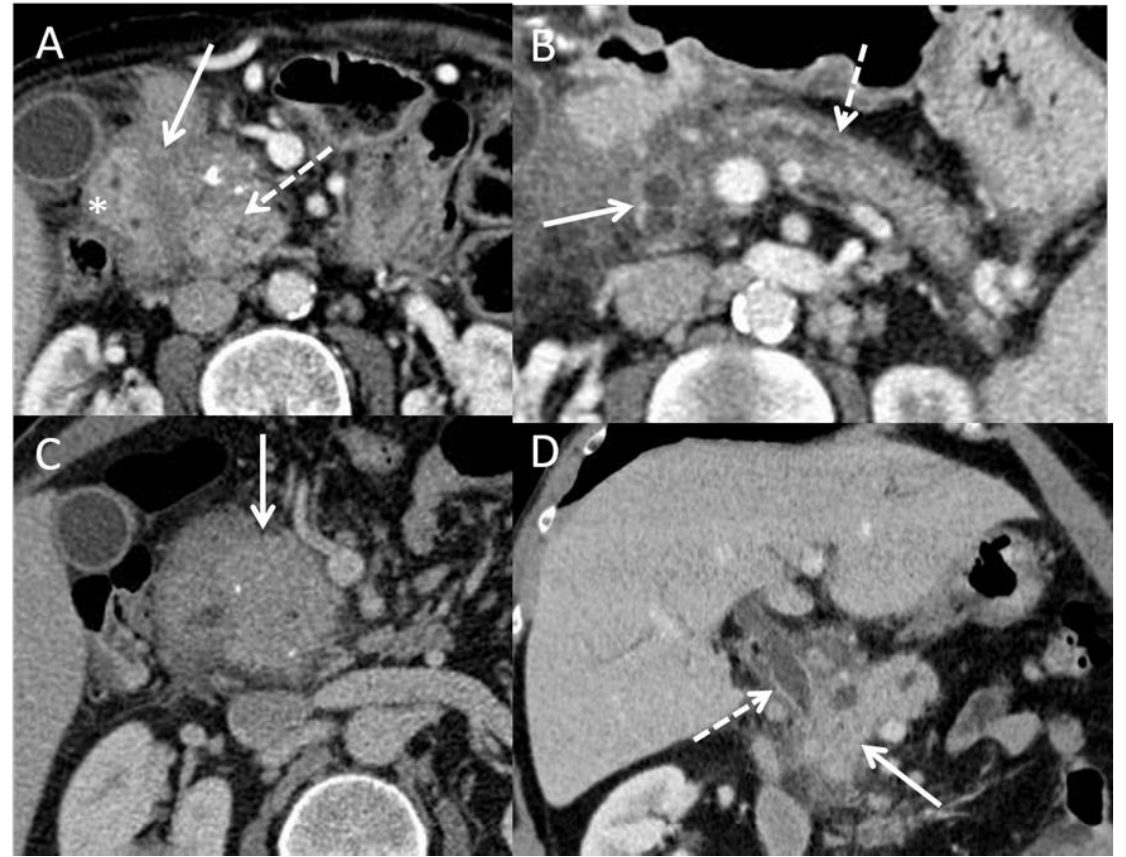
Figure 3. CT scan pictures of paraduodenal pancreatitis and pseudo-tumorous chronic pancreatitis. ( A ): paraduodenal pancreatitis developed on chronic pancreatitis. Hypodensity of the duodenal groove (white arrow) and hypertrophy of the calcified head of pancreas (dashed white arrow) (white star: duodenal wall). ( B ): paraduodenal pancreatitis with duodenal cysts (white arrow) associated with chronic pancreatitis with irregular caliper of Wirsung duct (white dashed arrow); ( C ): pseudotumorous chronic pancreatitis on the head of the pancreas (white arrow) without vessel infiltration; ( D ): pseudotumorous chronic pancreatitis on the head of the pancreas (white arrow) with stenosis of the common bile duct (white dashed arrow).